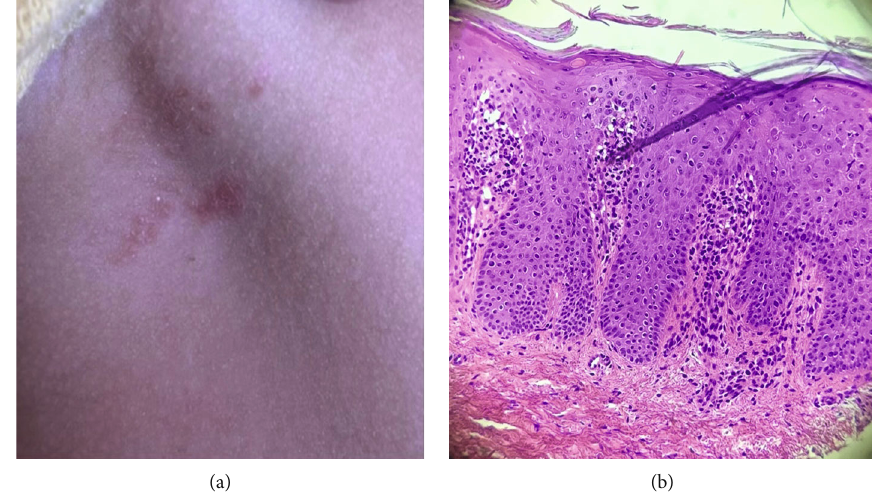
Figure 2: Erythematous papules and plaques with thin overlying scales on the right axilla (a). Histopathological examination (H&E stain, 200X) demonstrates psoriasiform acanthosis, thin supra-papillary plates, neutrophils in the stratum corneum, and a super fi cial perivascular lymphocytic in fi ltrate, con fi rming the diagnosis of psoriasis (b). H&E: hematoxylin and